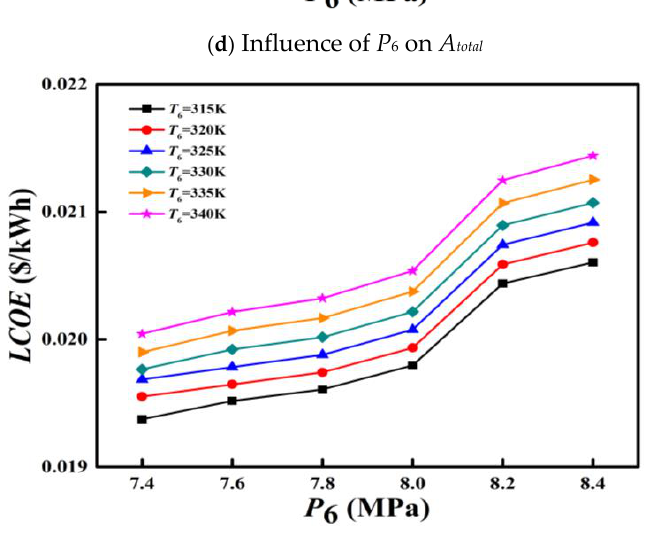
Figure 10. Influence of P 6 on the proposed S-(N 2 O-He) cycle.